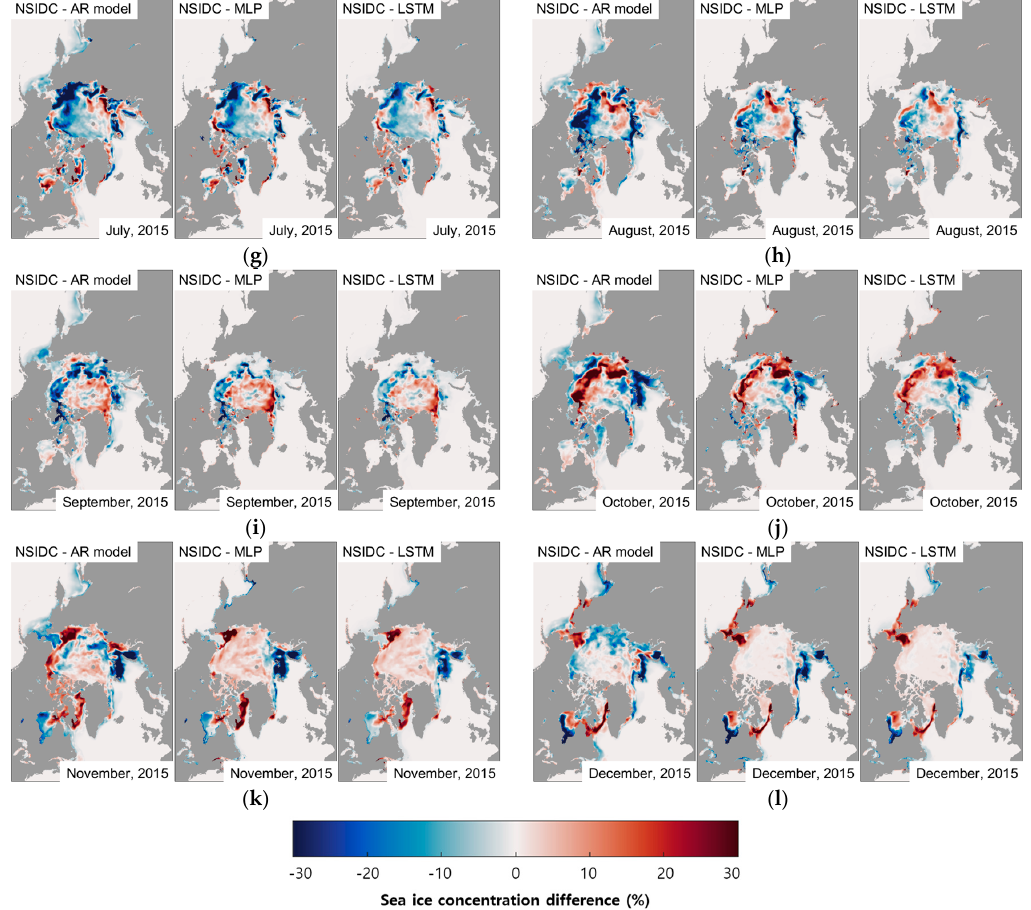
Figure 8. Monthly residual comparisons between the actual and three predicted SICs: ( a ) January; ( b ) February; ( c ) March; ( d ) April; ( e ) May; ( f ) June; ( g ) July; ( h ) August; ( i ) September; ( j ) October; ( k ) November; ( l ) December. Table 6. Comparison of monthly RMSE values for the long-term